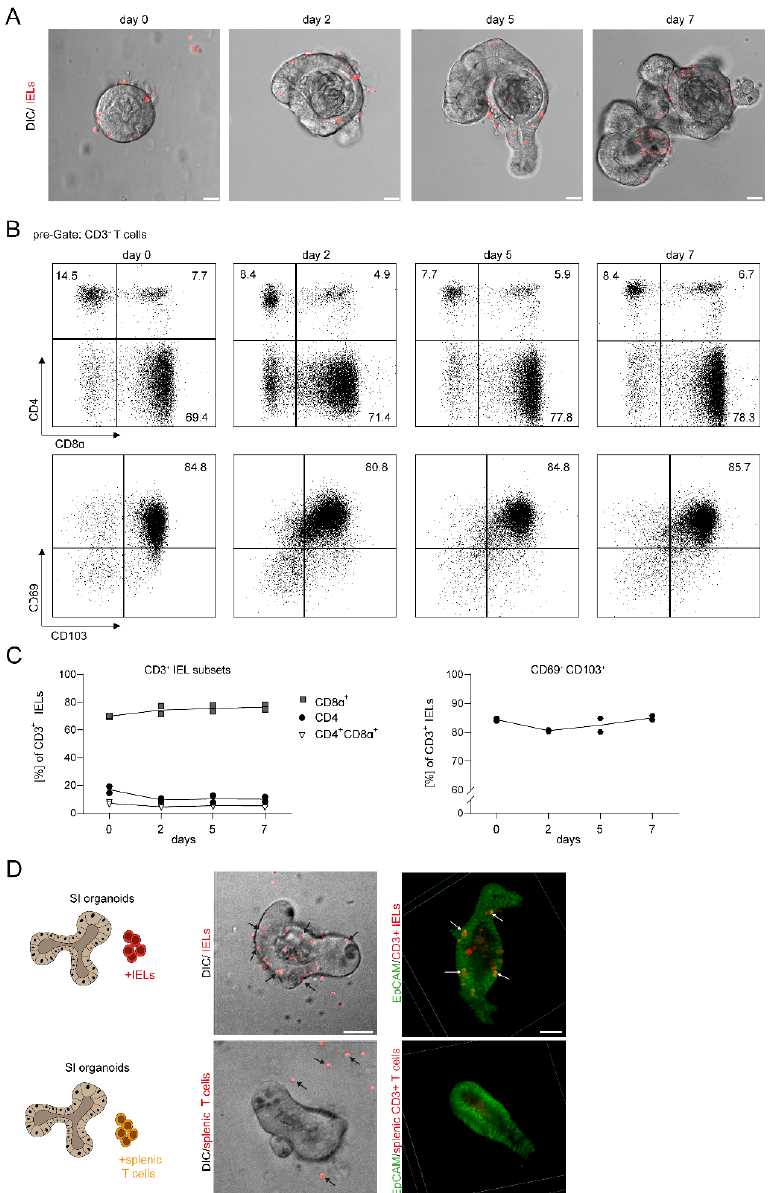
Figure 2. IELs remain alive, phenotypically stable, and localize to the IEC layer during a prolonged period of ex vivo co-culture. ( A ) IEL-IEC co-cultures with fluorescently pre-stained IELs (Cell Proliferation Dye, red) were monitored by confocal microscopy by SP5 in DIC from day 0 to day 7. Co-cultures were split before imaging. Scale bar 25 µ m. Representative images of at least three independent experiments are shown. ( B ) IELs were removed from IEL-IEC co- cultures at different time points as indicated, stained with fluorescently labeled antibodies directed against CD3, CD4, CD8 α , CD69, and CD103, and analyzed by flow cytometry. Representative FACS blots of two independent experiments are shown. ( C ) FACS-based kinetic analysis is shown for the expression and ratio of selected surface markers on CD3 + IELs obtained from IEL-IEC co-cultures as indicated. Results are pooled from two independent experiments. ( D ) Co-cultures were set up with small intestinal IEC organoids and either IELs or splenocytes from tdTOMATO CD4/CD8 reporter mice (red) as indicated. Co-cultures were analyzed by live cell imaging with confocal microscopy in DIC with the spinning disc (left) or after fixation and IF staining for EpCAM (right) with T cells from tdTOMATO CD4/CD8 mice. IELs and splenic T cells are shown in red. Arrows point to typical localizations of IELs and splenocytes, respectively. Scale bar 50 µ m. Co-cultures with T cells from tdTOMATO CD4/CD8 reporter mice were incubated overnight before imaging. Representative images of three independent experiments are